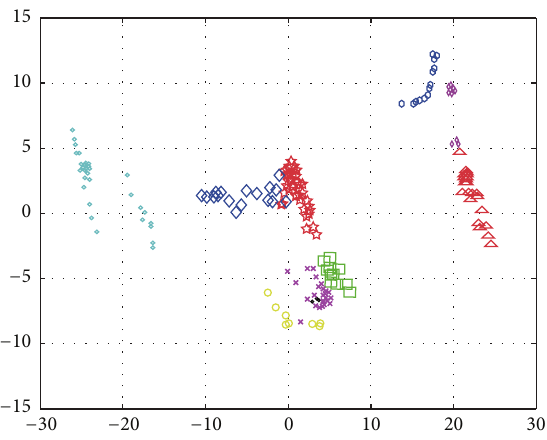
Figure 13: Clustering results obtained by